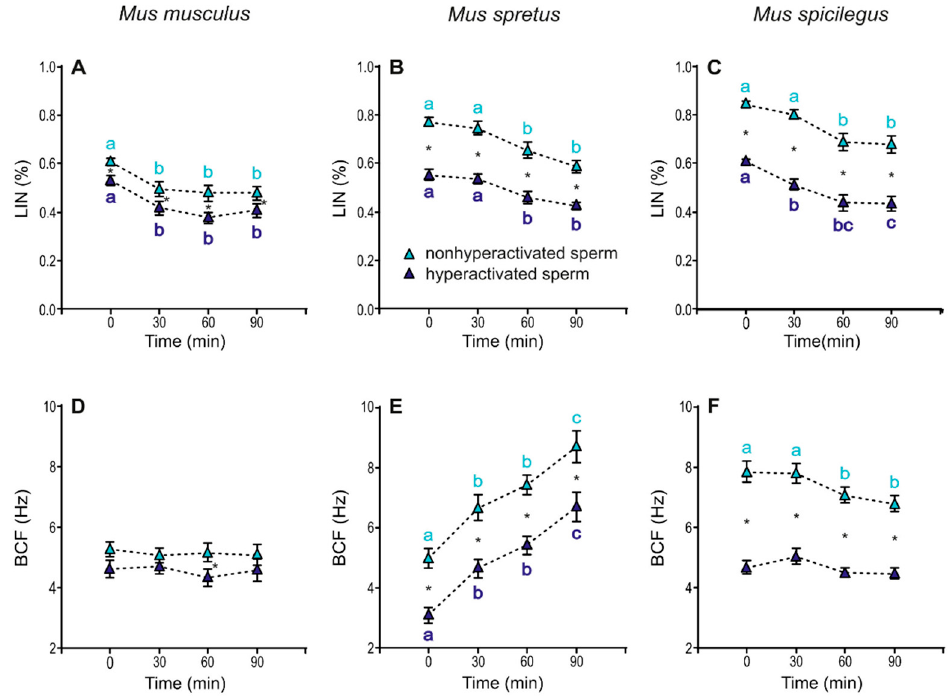
Figure 9. Variation in swimming parameters (LIN and BCF) of spermatozoa from three mouse species ( M. musculus , M. spretus , M. spicilegus ) under capacitating conditions (mT-BH medium under 5% CO 2 /air). Data are means ± SE ( n = 7 in M. musculus , n = 8 in M. spretus , and n = 6 in M. spicilegus ). Light blue triangles: non-hyperactivated sperm in capacitating conditions. Dark blue triangles: hyperactivated sperm in capacitating conditions. ( A – C ) Linearity (LIN) (VCL/VSL) (%). ( D – F ) Beat cross frequency (BCF) (Hz). ( A , D ) M. musculus . ( B , E ) M. spretus . ( C , F ) M. spicilegus . Asterisks indicate significant differences ( p < 0.05) between non-hyperactivated and hyperactivated sperm for the same time in a Fisher post-hoc test. Different letters between times of incubation for the same status (hyperactivated or non-hyperactivated) indicate statistically significant differences ( p < 0.05) in a Fisher post-hoc test. If two time-points of an incubation share any letter, the differences between them are not significant. No letters were used when a time-point of an incubation did not show any significant effect in the dependent variable.